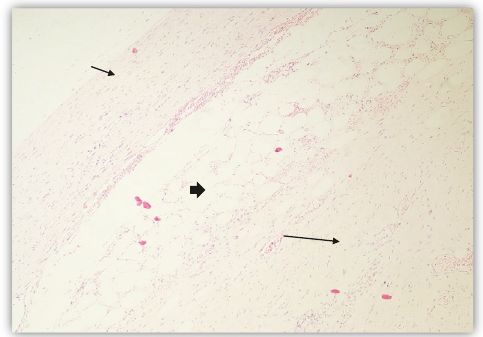
Figure 3: Myxoid Areas. H & E stain (400X).